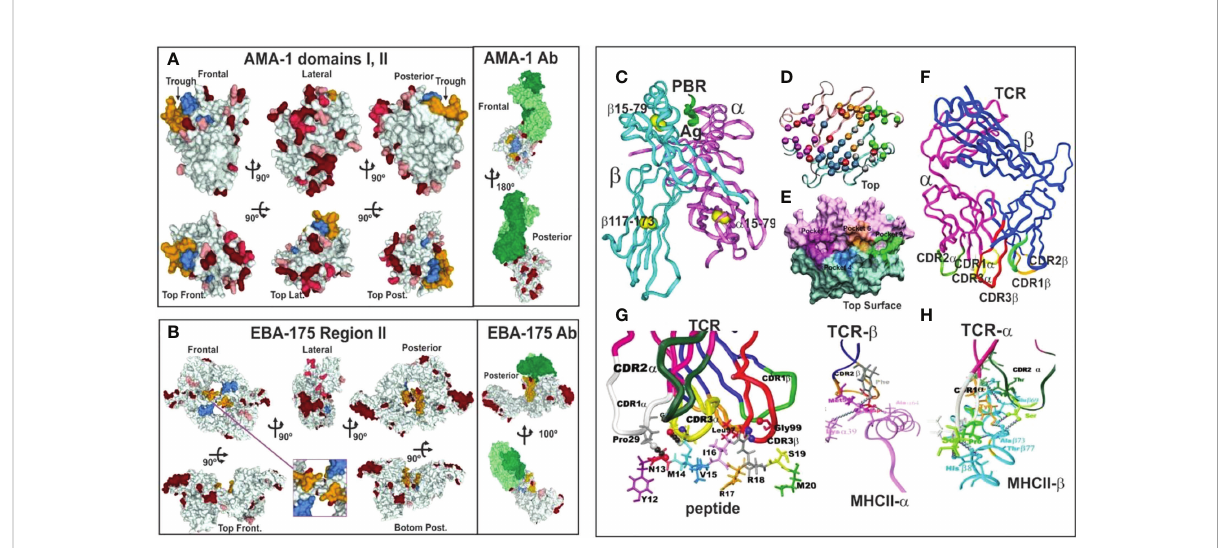
FIGURE 3 (A, B) 3D representation and polymorphism analysis of AMA-1 domain I and EBA-175 RII with mAb complex.Taking from Ref. 32. (A) cHABPs 4313 (blue) and 4325 (dark yellow) are far away from highly polymorphic regions in the AMA-1 recombinant fragment to which 1F9 mAb bind (lesser to greater polymorphism shown by pink, red to burgundy). (B) EBA-175 RII dimer showing hand-shake structure cHABPs 1779 (blue) and 1783 (dark yellow) in the box; alongside, mAb R218 bound far away from these cHABPs in the F1 domain. (C) Front view of class II (HLA- DR b 1*0101) molecule 3D structure (PDB code: 1DLH) (16), showing the a -chain (light pink) and b -chain (clear blue ribbon). (D) Top-view, ribbon representation of HLA-DR b 1*0401, showing a - and b -chain aa forming Pockets 1 (fuchsia), 4 (dark blue), 6 (light brown) and 9 (green). (E) Front view, Connolly representation of HLA-DR b 1*0101 3D structure with a - and b -chains forming the PBR where mHABP aa sidechains will be accommodated (according to established colour code). (F) TCR- a (dark pink) and b -chain (dark blue) with CDR1 a (white), CDR2 a (dark green), (G) CDR3 a (yellow), CDR1 b (light green), CDR2 b (orange) and CDR3 b (red) above peptide 24112 showing interaction via H-bonds (grey balls) with HA-1.7TCR, modi fi ed according to V b 12 clone 3 sequence from protected Aotus monkeys. (H) TCR interactions with MHC a - and b - residues to stabilise complex binding ( C, D, F – H taking from Ref.